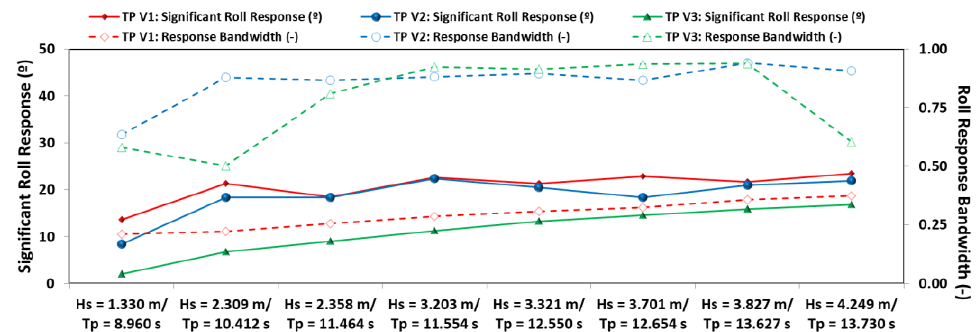
Figure 12. ζ m 0,4 (left) and (cid:101) 4 (right) for the HS sub-variants. Figure 12. 𝜁 𝑚0,4 (left) and 𝜖 4 (right) for the HS sub-variants. Figure 12. 𝜁 𝑚0,4 (left) and 𝜖 4 (right) for the HS sub-variants. Figure 12. 𝜁 𝑚0,4 (left) and 𝜖 4 (right) for the HS sub-variants.